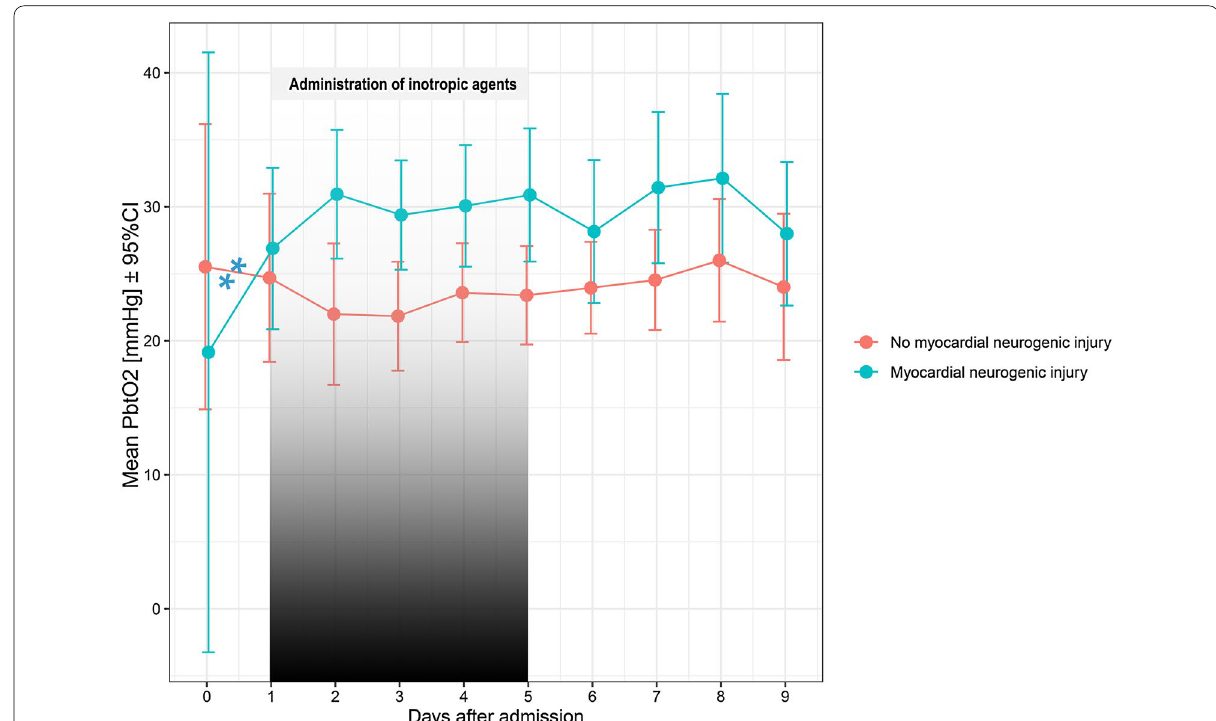
Fig. 4 Patients with stunned myocardium had higher P bt O 2 levels as compared to those without stunned myocardium ( p ( p 0.003) rose from day 0 to day 1 in patients with stunned myocardium. The median administration of inotropic agents ranged from days 1 (1–3) = to 5 (4–8) within the monitoring